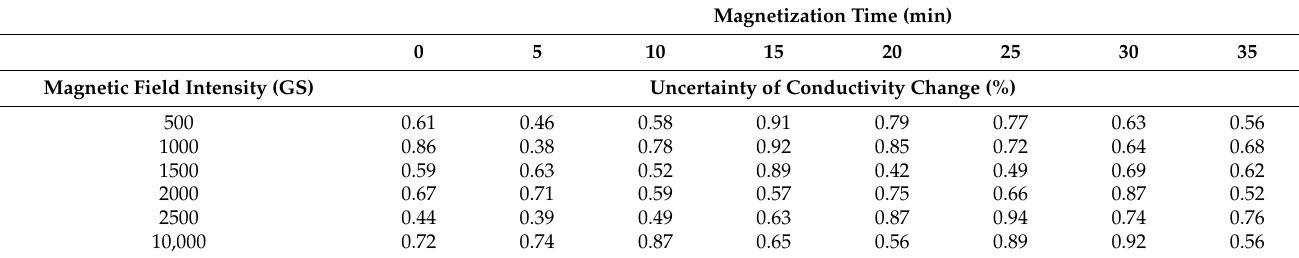
Table 1. The uncertainty of conductivity in these